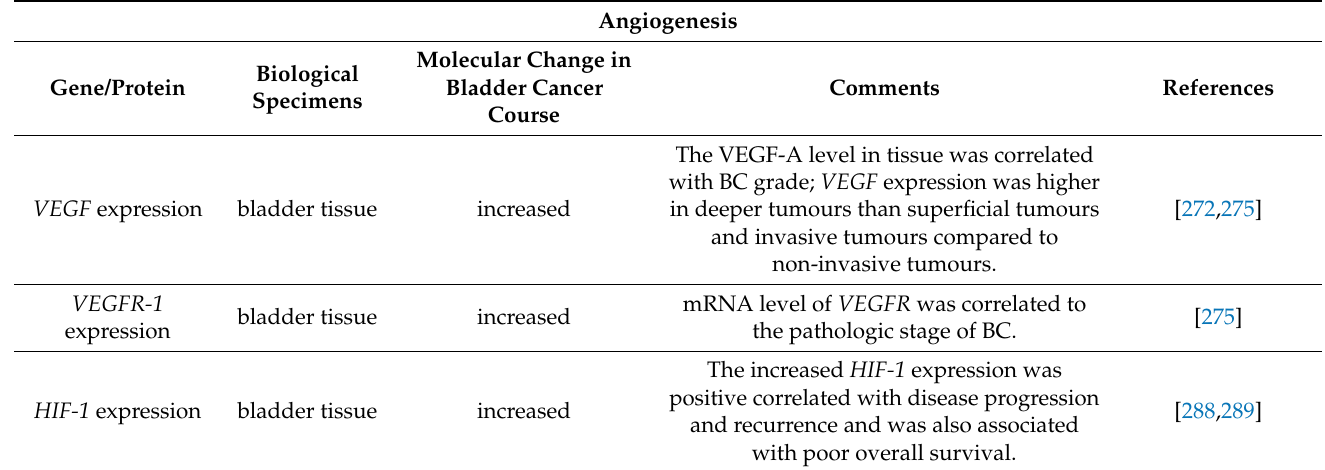
Table 7. The factors of the angiogenesis pathway involved in